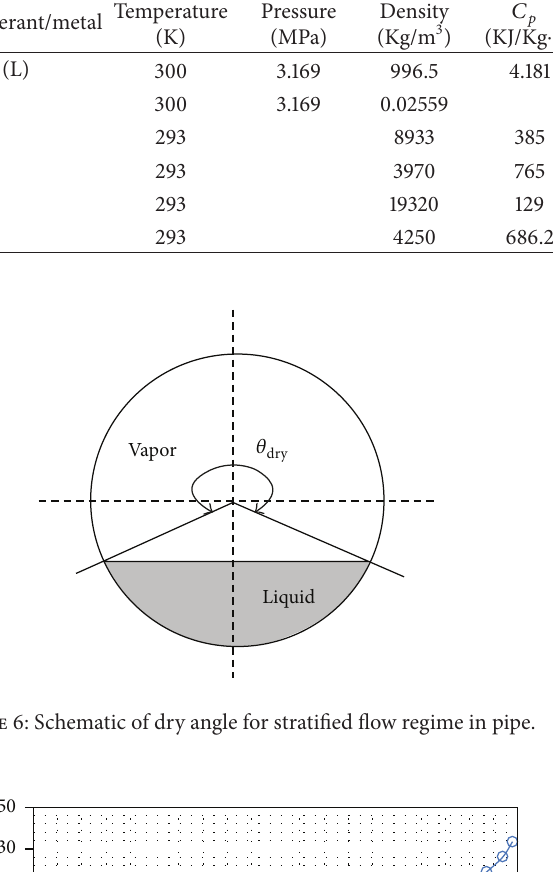
Figure 6.By turning the effects of nanoparticles off in the present model, results are compared to those of Ursenbacher et al. for the same working fluid and flow conditions (the applied working fluid is R22 in a pipe of 1.58 cm diameter).